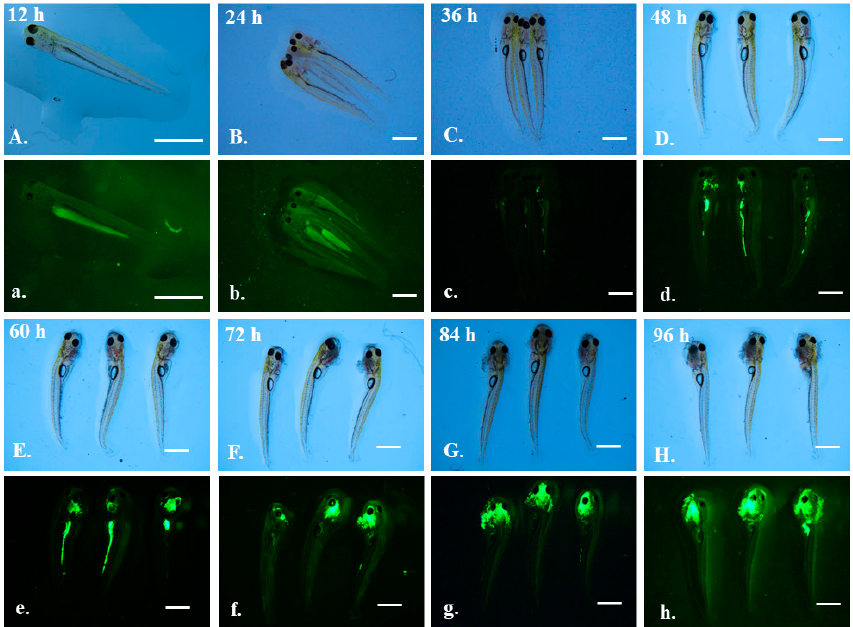
Figure 4. The larvae of grass carp after exposure to 5 µ m green fluorescent microplastics. Photographs were taken under a brightfield microscope (capital letters A – H ) and green fluorescent microscope (lowercase letters a – h ). Observation time was labeled in the figure. Scale bar = 2